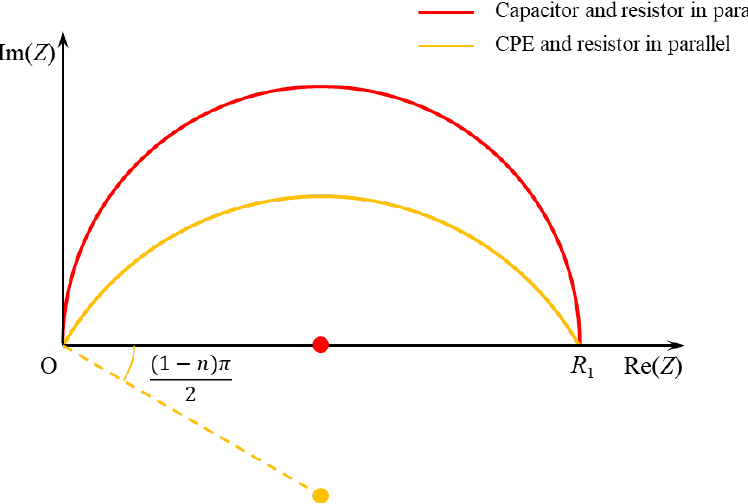
Figure 2. The Nyquist curve of two different equivalent circuits.